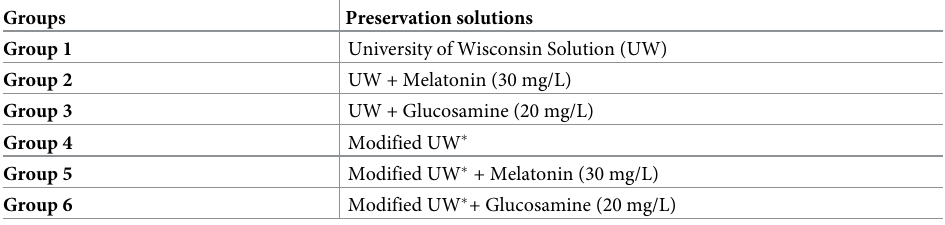
Table 1. Preservation solutions used in experimental studies.